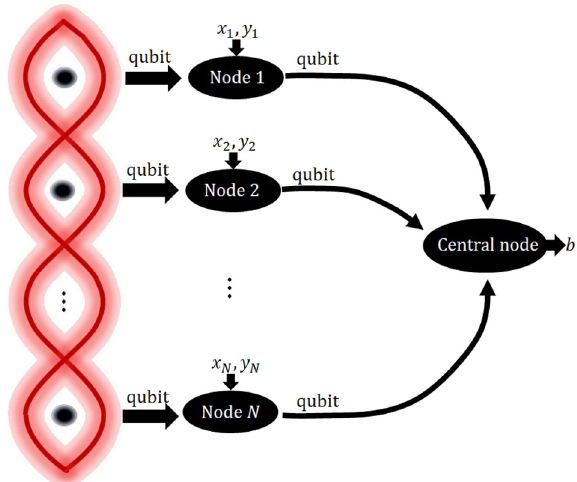
Fig. 1 Communication network. Independent nodes share an N -qubit entangled state on which they perform qubit transforma- tions. The shares are communicated to a central node which deterministically accesses information about the collective inputs of the N other nodes by performing an N -qubit BSM. This gives rise to a quantum-over-classical advantage which enables certi fi cation of the degree of entanglement present in the measurement of the central node.